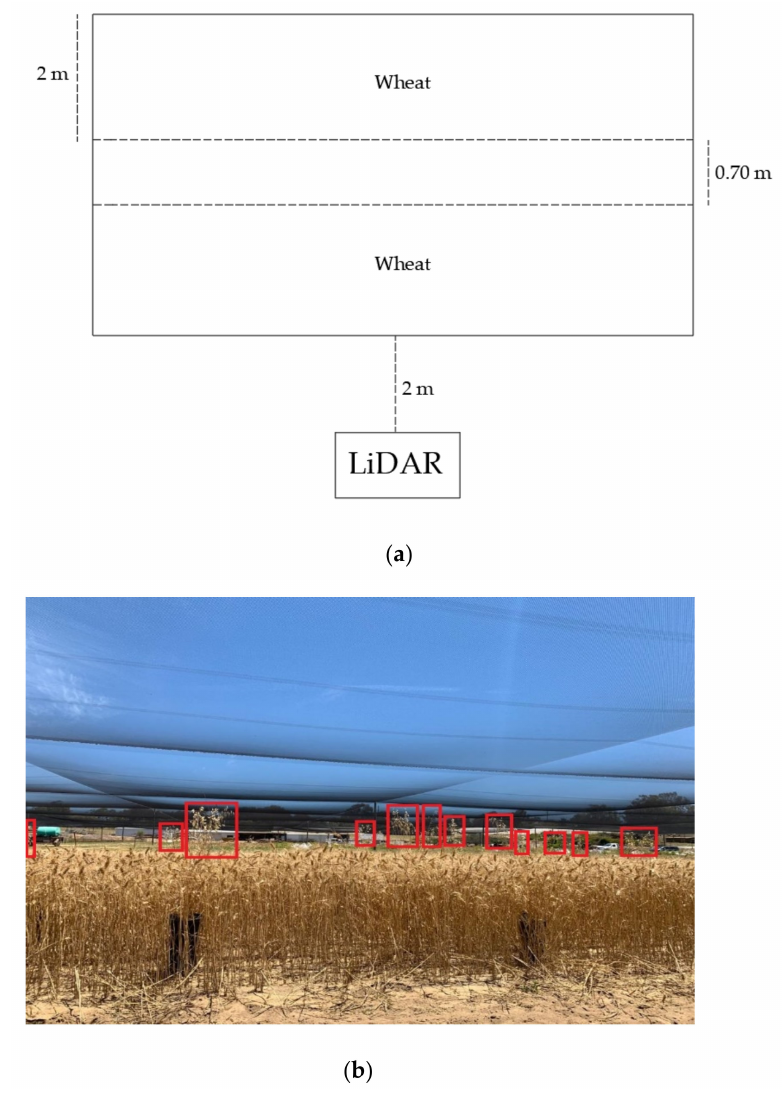
Figure 3. Scanning weed pots in the wheat plot, ( a ) wheat plot set up at the UWA Shenton Park Field Station ( b ) Weed pots elevated using plastic pots and randomly distributed in the wheat plot. When the wheat in the plot was at Zadoks growth scale 91 [34], the pots containing Avena fatua and Sonchus oleraceus were placed into the plot on upturned empty plastic pots, ensuring that target weeds were protruding above the nominal wheat height that ranged between 0.60–0.82 m. The height of Avena fatua and Sonchus oleraceus pots ranged between 0.80–1.06 m and 0.71–0.99 m, respectively. The LiDAR was mounted on a stand at a height of 1.08 m above the ground, pointing toward the wheat at an angle of 15 ◦ below the horizontal (Figure 3b). The LiDAR was static and scanned the wheat plot at 2 m distance from the first row of wheat. Three scans were performed: the first conducted by placing 21 Avena fatua pots at random in the wheat as described above; the second one by using 14 Sonchus oleraceus pots; and the third one by placing a mixture of 14 Avena